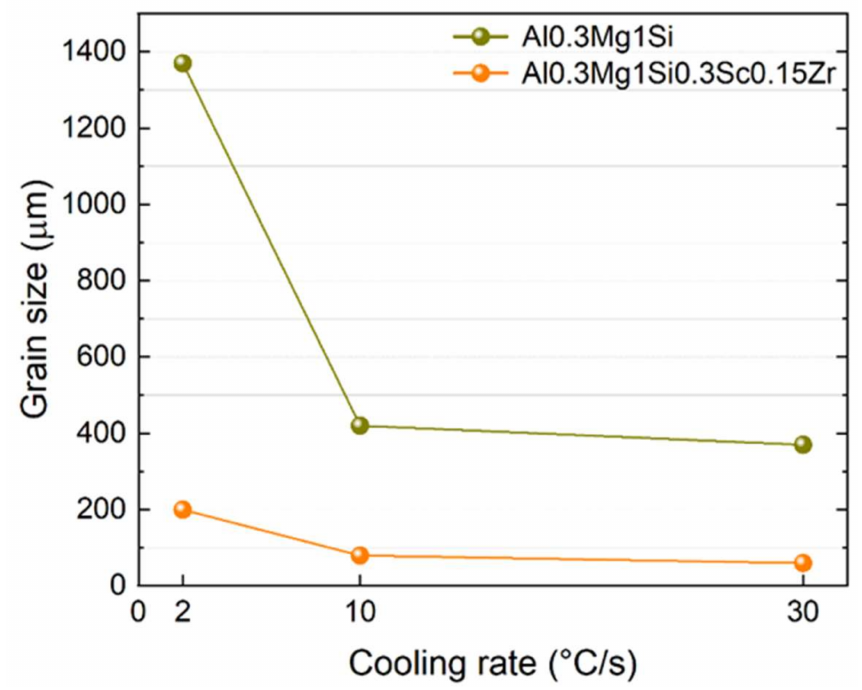
Figure 3. Grain size of alloys depending on the cooling